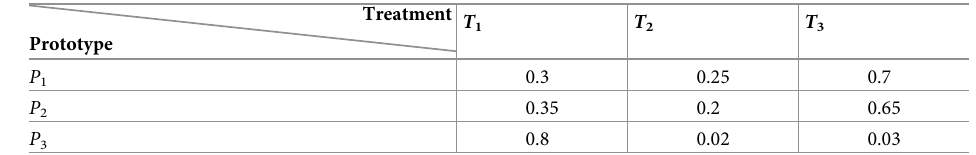
Table 1. High variance across prototypes.